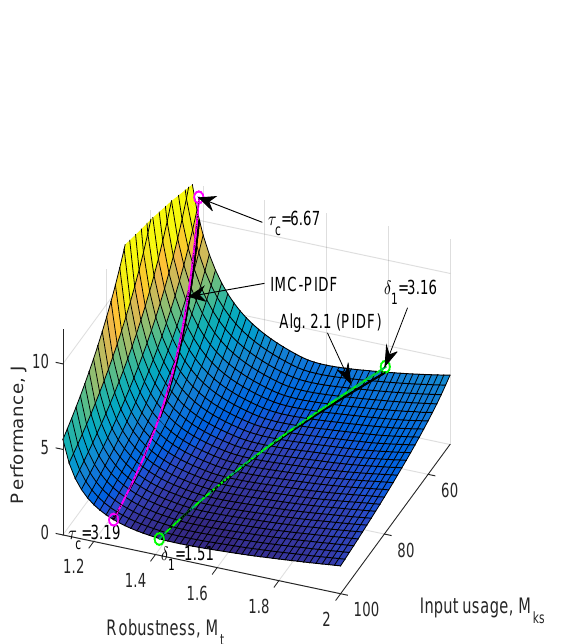
Figure 11: Example 3.6: J vs. M ks and J vs. M t trade-off curve plots. Comparing Alg. 2.1, IMC-PIDF vs. the PO-PID controllers for the process model at row 6, col. 2 in Table 3. col. 1 is Alg. 2.1 (PIDF) and col. 2 is IMC-PIDF. Table 6: Summarised results from Sec. 3.1. Compar- ing SIMC, K-SIMC and the proposed